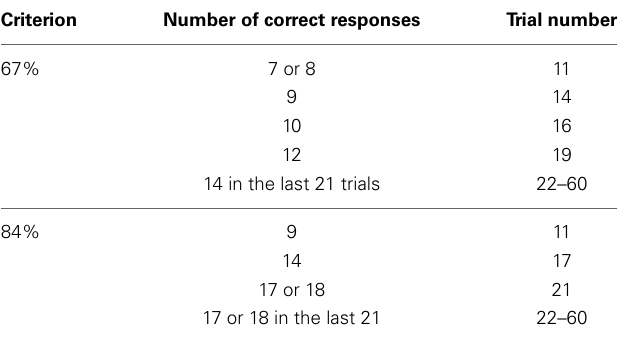
Table 1 | Number of correct responses required (middle column) at each training trial (right column) to reach the 67 and 84% learning